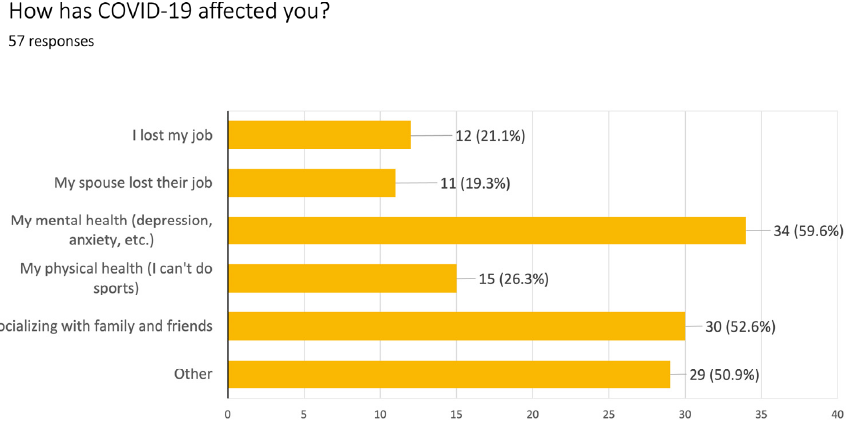
Figure 5. Bar graph (translated from Spanish) based on classroom survey about how COVID-19 is affecting people in their social network.